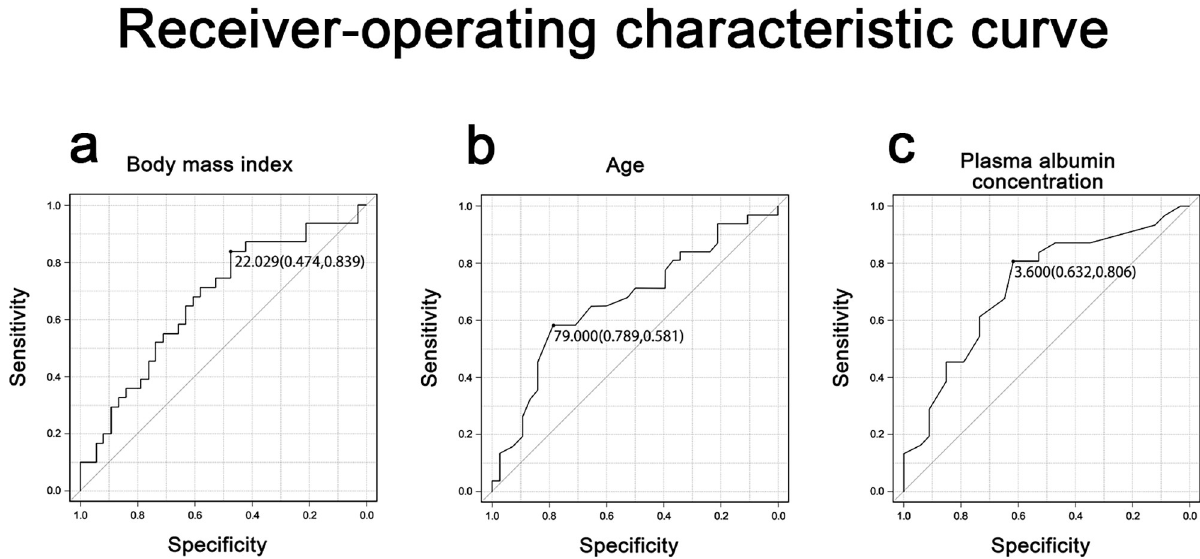
Fig 1. Receiver–operating characteristic curve. (a) Time to extubation � 15 min for body mass index (BMI) over 22.0 kg/m 2 . (b) Time to extubation � 15 min for age over 79.0 years. (c) Time to extubation � 15 min for plasma albumin concentration below 3.60 g/dl.